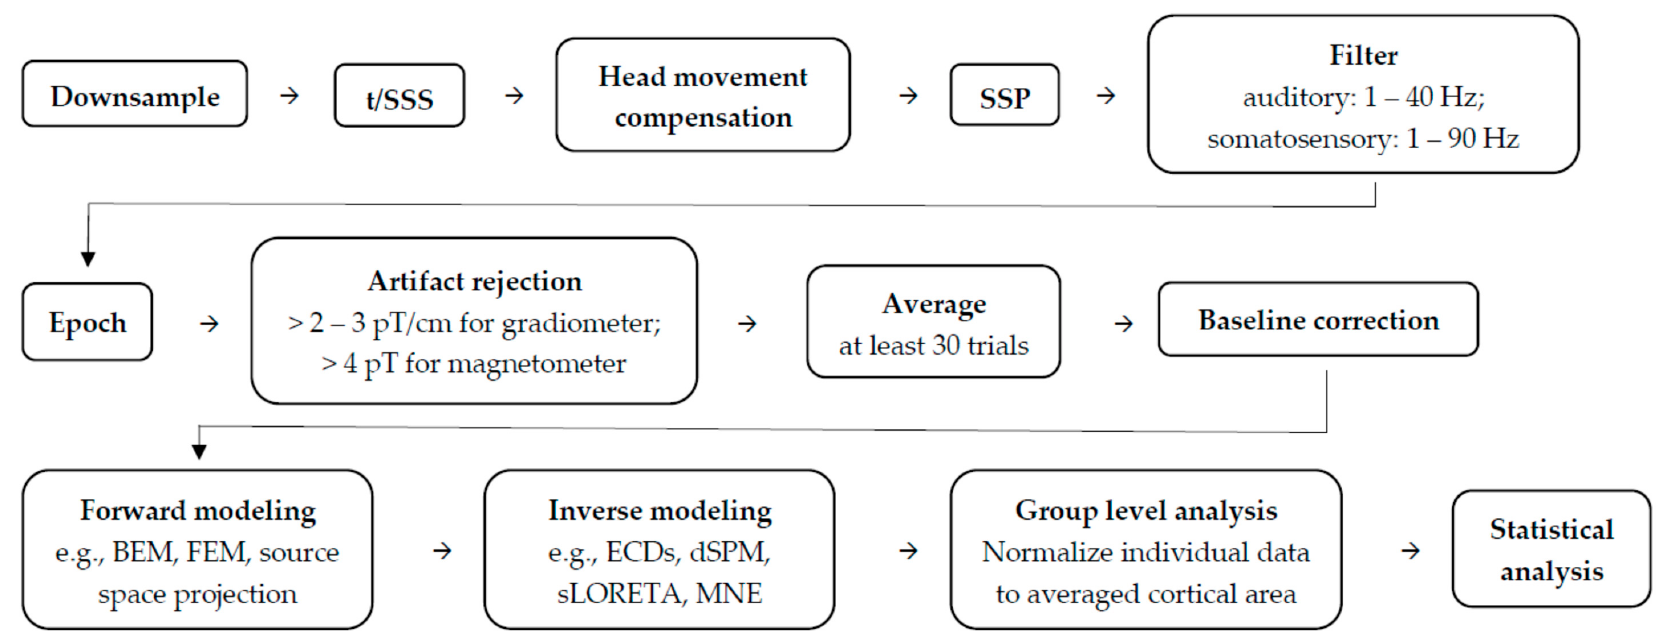
Figure 3. Summary of typical practices for infant MEG data preprocessing and analysis. The order of the MEG signals preprocessing varies from research topics. In order to organize the steps, we summarized the preprocessing procedures that include head movement compensation, which is an essential part for further source analysis in infant MEG studies. (also see [92,93] ).